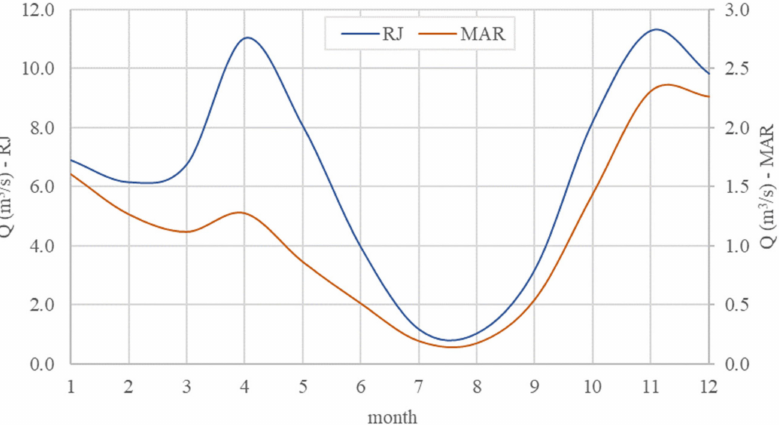
Figure 3. Monthly discharges for Rjeˇcina Spring (RJ) and Martinš´cica hydrological station (MAR) from 1975 to 2016. Due to a lack of data, the years 2001, 2007, and 2008 are not included in the analysis. The months of the year are represented by the numbers 1–12, beginning with January and ending with